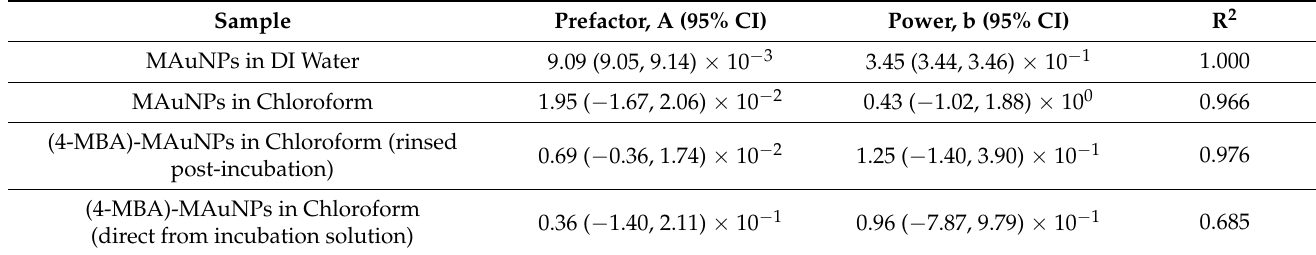
Table 3. Power law fit parameter values with 95% confidence intervals (CI) and R 2